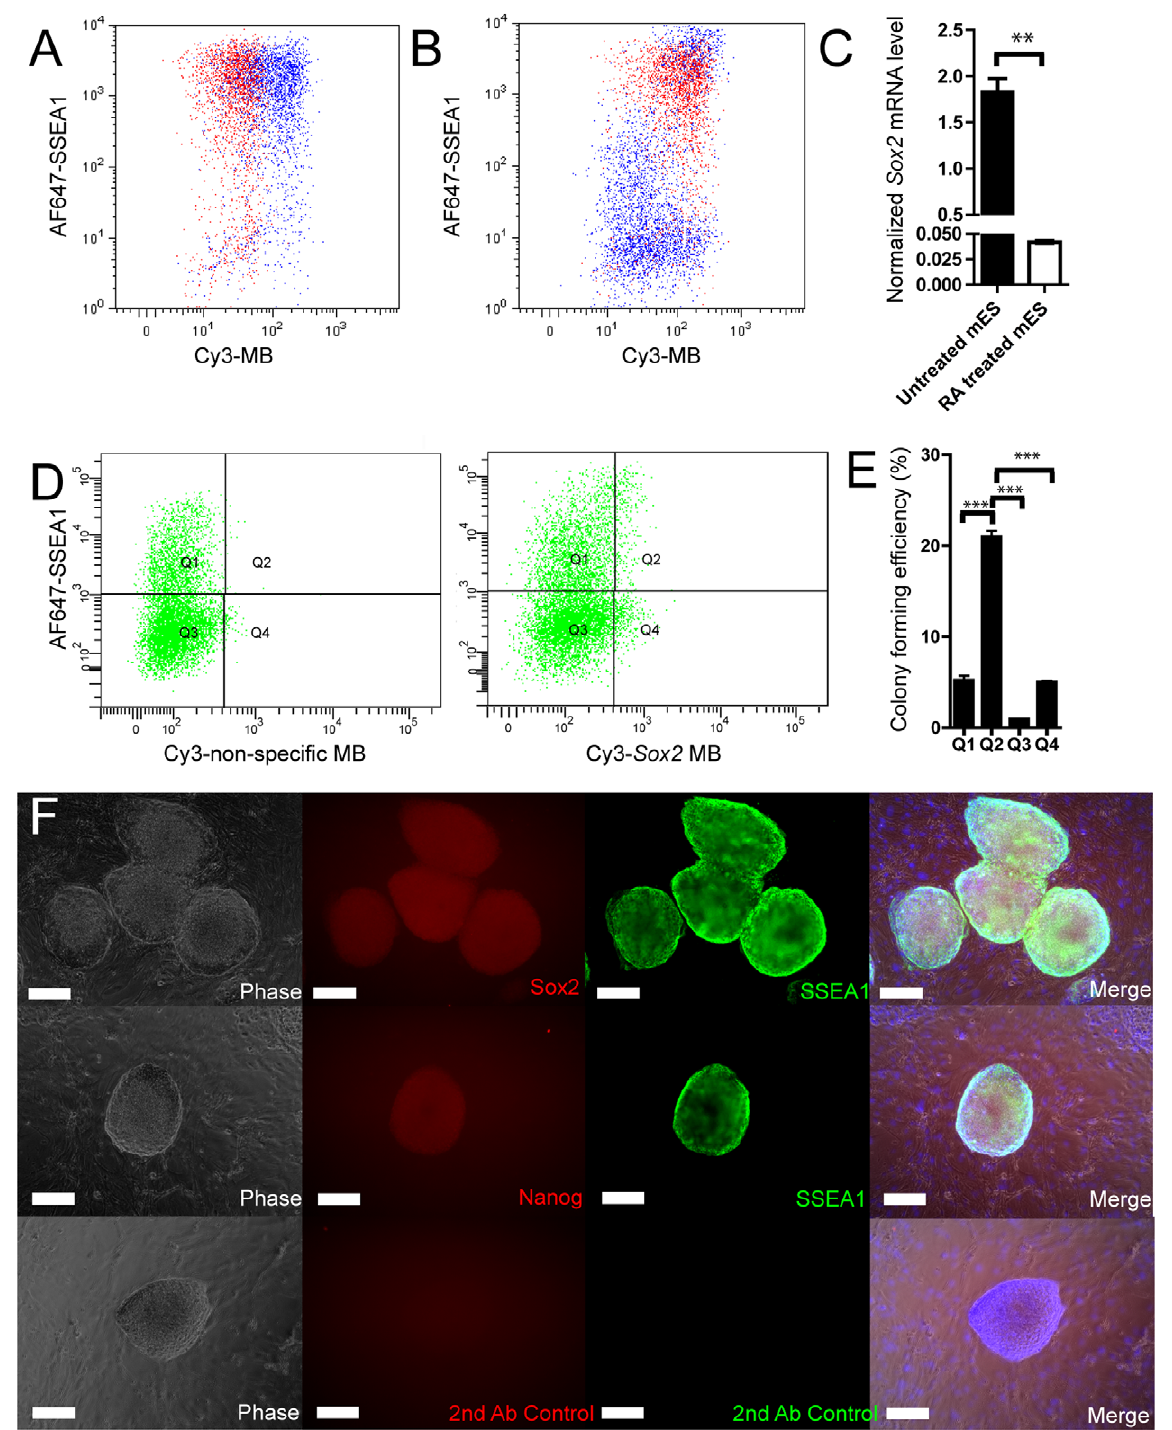
Figure 3. Detection of Sox2 -MB in differentiated mES cells. (A) mES cells stained for SSEA-1 together with the Sox2 -MB (blue dots) and the nonspecific-MB (red dots). (B) SSEA-1 stained differentiated mES cells treated with Sox2- MB (blue dots) were compared to SSEA1 stained undifferentiated mES treated Sox2- MB (red dots). (C) Undifferentiated mES cells and mES cells differentiated by exposure to RA were analyzed with RT-PCR. (D) Four quadrants (Q1, Q2, Q3 and Q4) of the differentiated mES cells were selected by comparing the nonspecific-MB fluorescent signal with the Sox2 -MB fluorescent signal. (E) The double-positive sorted cell populations (Q2: Sox2-MB + and SSEA1 + ) formed significantly more undifferentiated colonies compared to the positive-negative sorted cell populations (Q1: Sox2-MB - and SSEA1 + Q4: Sox2-MB + and SSEA1 2 ), and the double-negative sorted cell population (Q3: Sox2-MB - and SSEA1 2 ). (F) Undifferentiated colonies were positively stained for Sox2, Nanog and SSEA1 (Scale bar =200 m m). Error bars represent the mean 6 SEM. Asterisks denotes statistical significance (n=3 samples ** p , 0.01, n=4 samples *** p , 0.001).